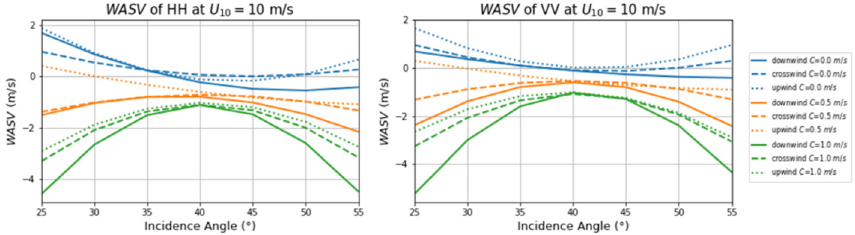
Figure 5. The relationship between WASV and incidence angle at a wind speed of 10 m/s for HH and VV polarizations. The swell direction was 0°, amplitude was 0.5 m, and wavelength was 200 m. Other input parameters were set to the values indicated in Table 1. The magnitude of the current velocity is indicated by color: blue indicates the absence of current (0 m/s), yellow indicates moderate current velocity (0.5 m/s), and green indicates high velocity (1.0 m/s). The wind direction is indicated by line style: a solid line indicates downwind direction, a dashed line indicates crosswind direction, and a dotted line indicates upwind direction.